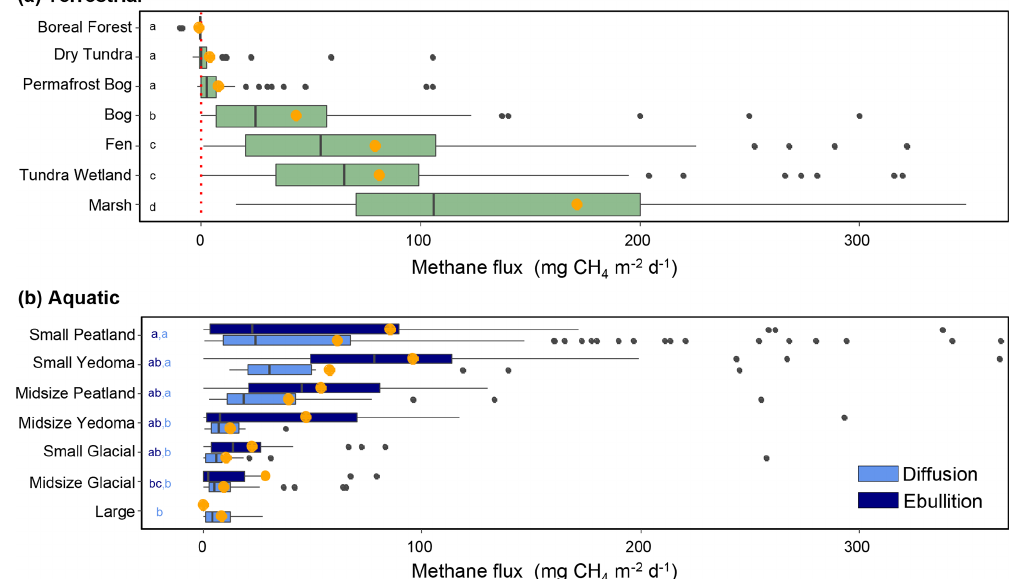
Figure 9. Relationship between methane flux and BAWLD land cover classes. (a) Terrestrial fluxes per class. (b) Aquatic fluxes including diffusion and ebullition per class. Orange dots represent the arithmetic mean flux values, and black lines represent median flux values. Boxes represent 25th and 75th percentiles. Outlier fluxes over 380 are not shown. The letters represent significant differences in fluxes among classes, wherein bars with the same letters are not significantly